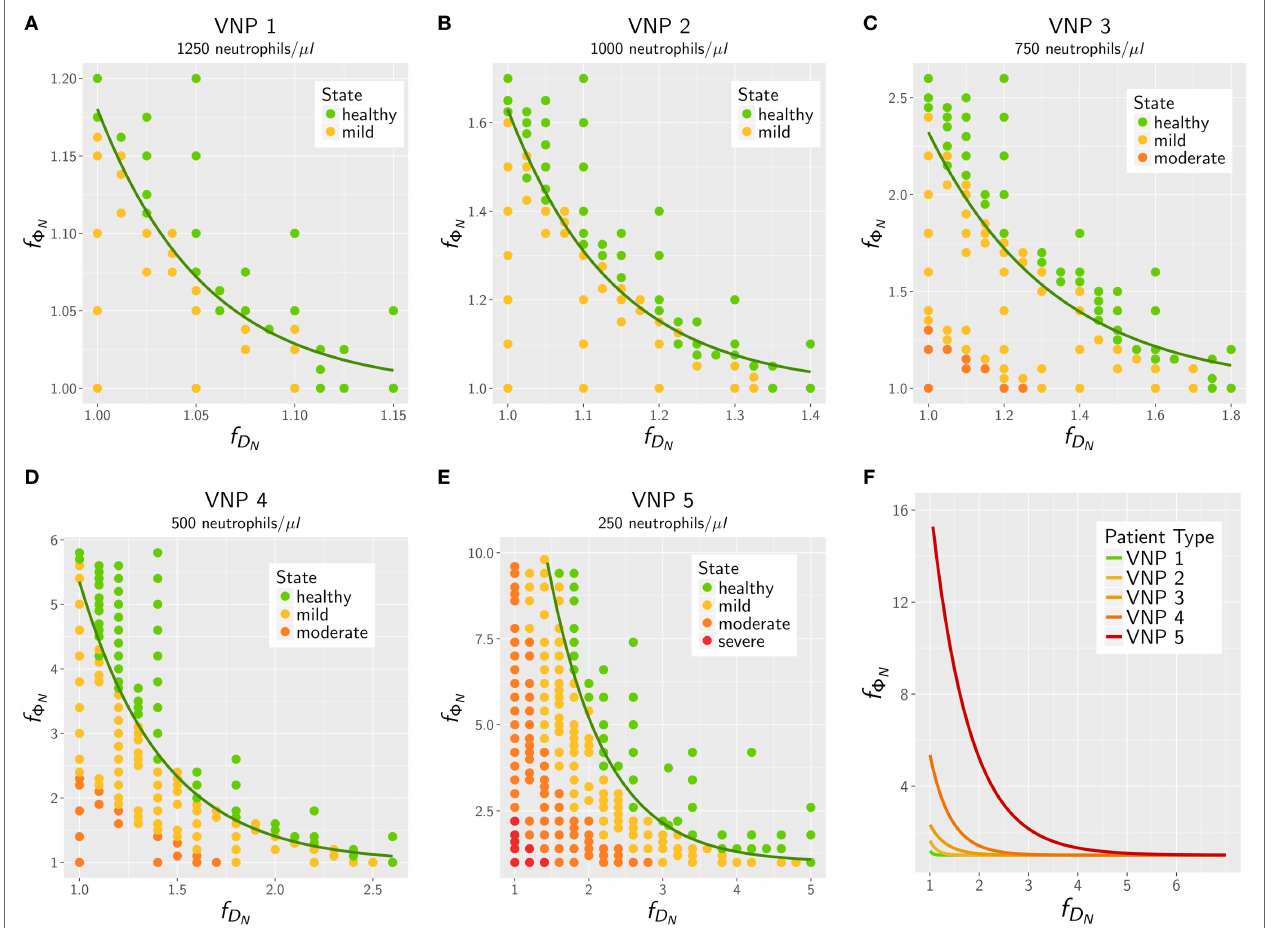
FIGURE 7 | In silico treatment of virtual neutropenic patients (VNP) infected with Candida glabrata was simulated using the agent-based model. Stepwise increase of phagocytosis rate and diffusion coefficient of neutrophils was performed for VNP with various severity degrees of neutropenia: VNP1–5: 1,250 (A) , 1,000 (B) , 750 (C) , 500 (D) , and 250 (E) neutrophils/ μ l. Simulated points are classified according to the previously determined patterns: green points show a non-neutropenic infection outcome, yellow points show an infection outcome comparable to a mild neutropenia, orange points show an infection outcome comparable to a moderate neutropenia, and red points show an infection outcome comparable to a severe neutropenia. Solid lines depict the fitted exponential function f Φ at the transition to the non-neutropenic infection outcome. For comparison, the fitted curves for the five VNP with their severity degrees of neutropenia are shown in panel (F)